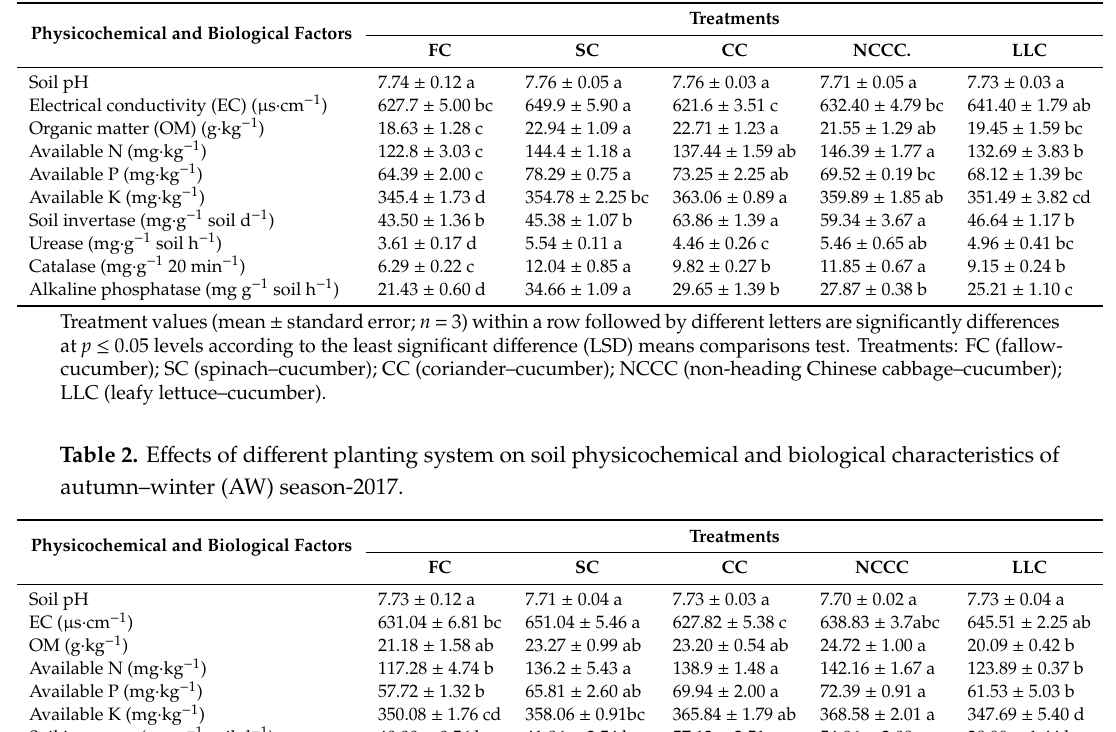
Table 1. E ff ects of di ff erent winter catch planting system on soil physicochemical and biological characteristics of winter–spring (WS) season-2017.